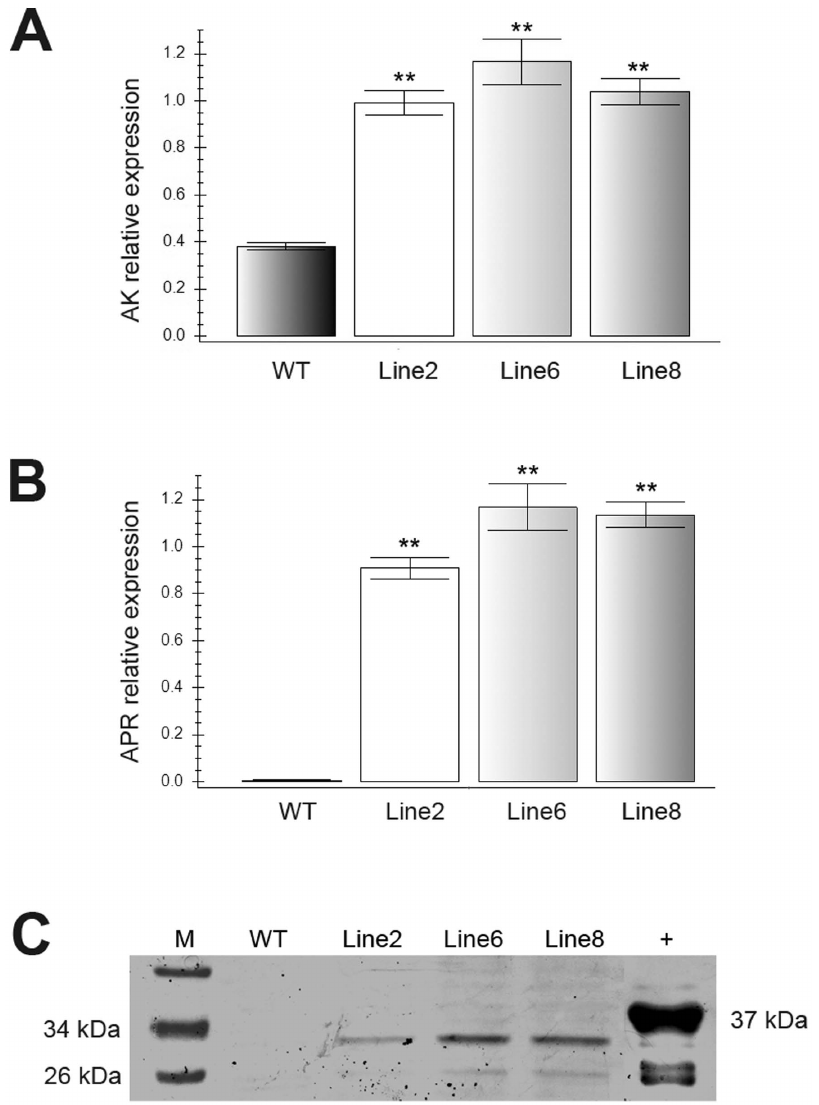
Figure 3. RT-qPCR and Western blot analysis of transgenic alfalfa plants. A. AK relative expression level in RT-qPCR analysis, Lane WT: wild- type line; Lane 2,6,8: Line 2,6,8 transgenic alfalfa lines. Each bar represents the mean of three biological replicates 6 SE. ** represents statistically significant differences (P , 0.01). B. APR relative expression level in RT-qPCR analysis, Lane WT: wild-type line; Lane 2,6,8: Line 2,6,8 transgenic alfalfa lines. Each bar represents the mean of three biological replicates 6 SE. ** represents statistically significant differences (P , 0.01). C. Western blot assay of expression of APR protein in transgenic alfalfa lines. The total soluble protein extracted from the young leaves of the transgenic lines and non- transformed negative controls. Lane WT: wild-type line, Lane Line2, Line6, Line8: three transgenic lines; Lane + : 6 6 His-APR fused protein; Lane M: PageRula rTM prestained protein ladder (Thermo scientific,USA). 26 kDa and 34 kDa indicate the standard marker bands; 37 kDa indicates the size of 6 6 His-APR fused protein.